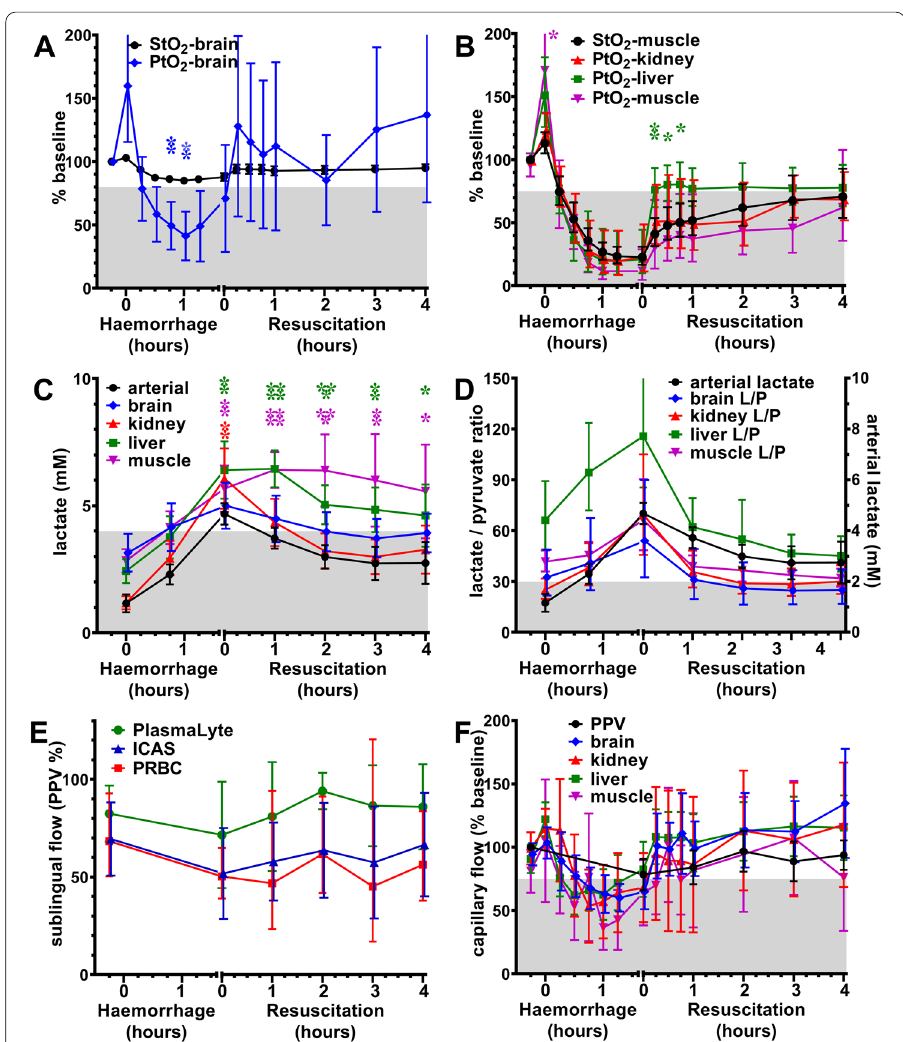
2 in brain. B Liver PtO 2 recovered (> 75% baseline) before other tissues and muscle StO 2 . C Arterial lactate was associated with brain and kidney lactate but delayed liver and muscle lactate clearance (< 4 mM; baseline mean SD). D Arterial lactate was associated with recovery in organ‑specific lactate/pyruvate + ratios (< 30). E Sublingual capillary flow (proportion perfused vessels; PPV) recovered similarly between treatment groups; ( F ) and an increase in sublingual capillary flow indicated that organ‑specific capillary flow